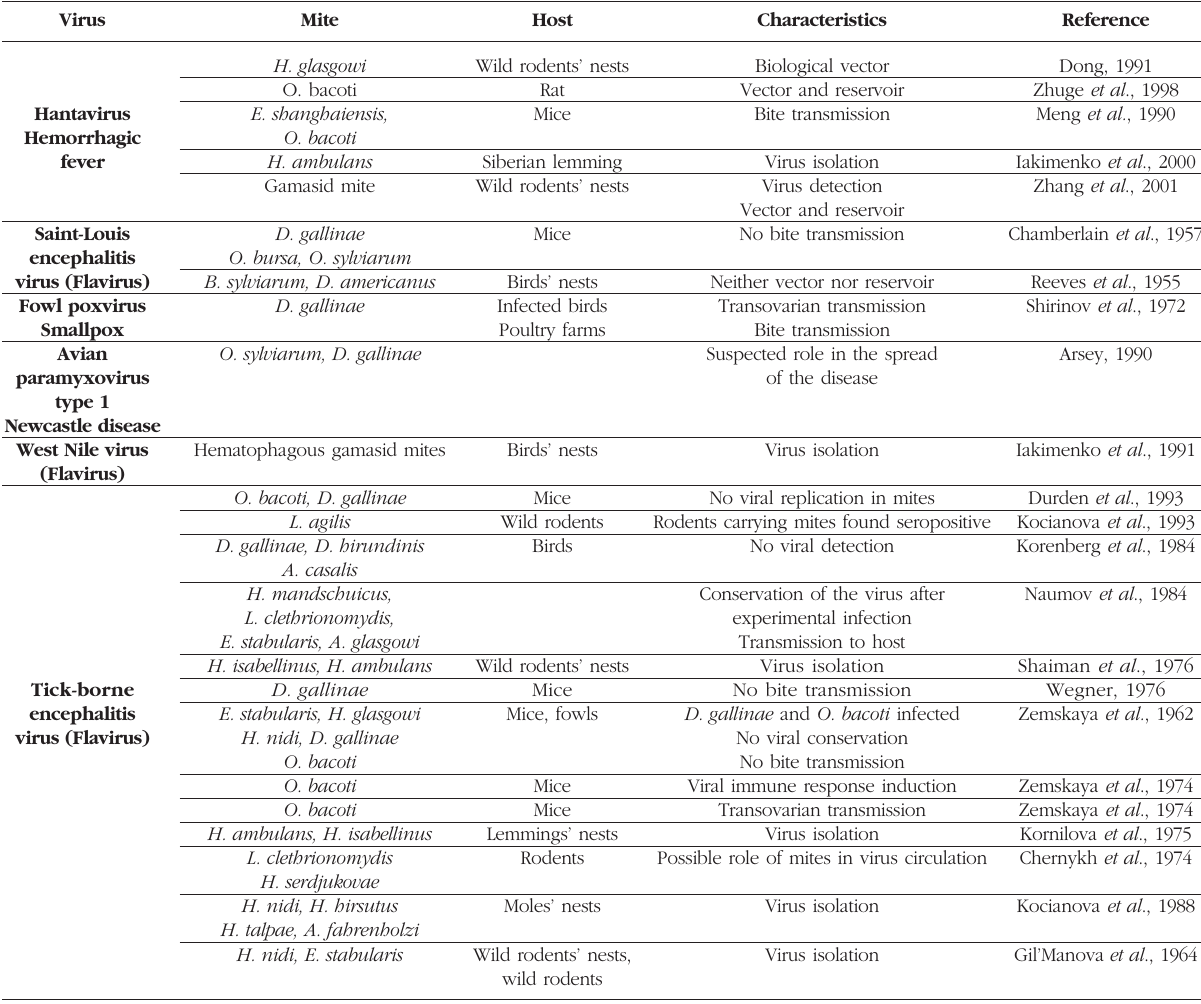
Table II. – Viruses likely to be transmitted by dermanyssoid mites (Equine encephalitis caused by Togavirus are shown in Table V). ( A. casalis = Androlaelaps casalis, A. fahrenholzi = Androlaelaps fahrenholzi, A. glasgowi = Androlaelaps glasgowi, B. sylviarum =